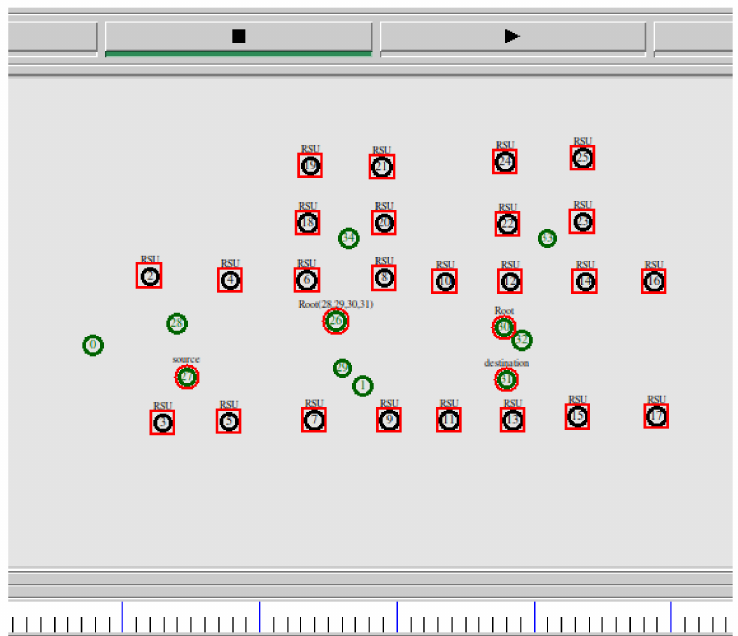
Figure 3. Root nodes in the network.